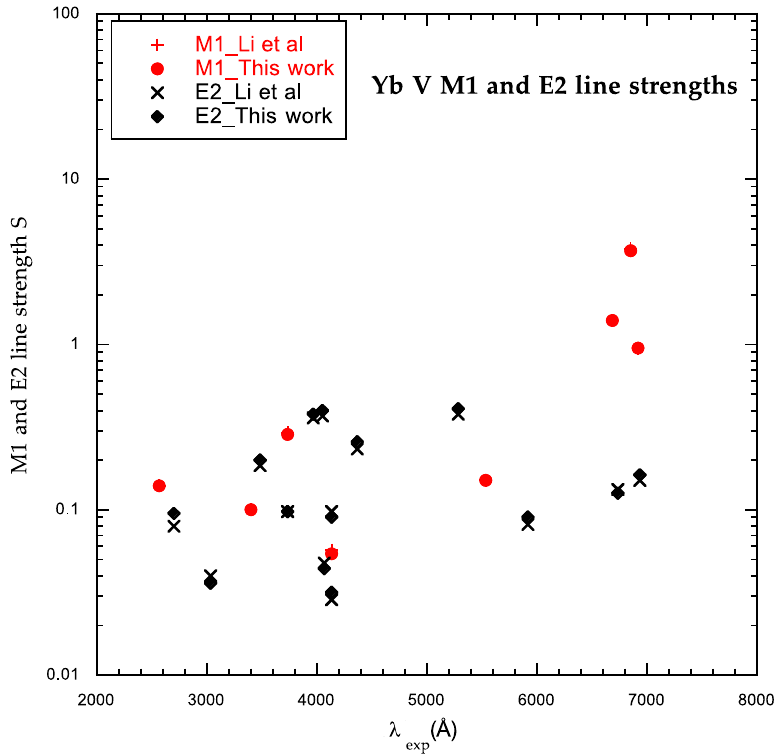
Figure 2. Magnetic dipole (M1) and electric quadrupole (E2) line strengths in Yb V for lines between 2000 and 8000 Å.